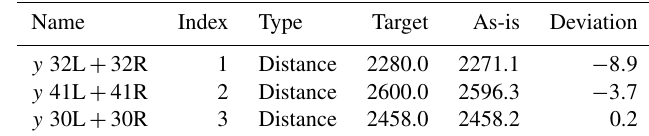
Table 1. Examples of dimensions (in millimetres).